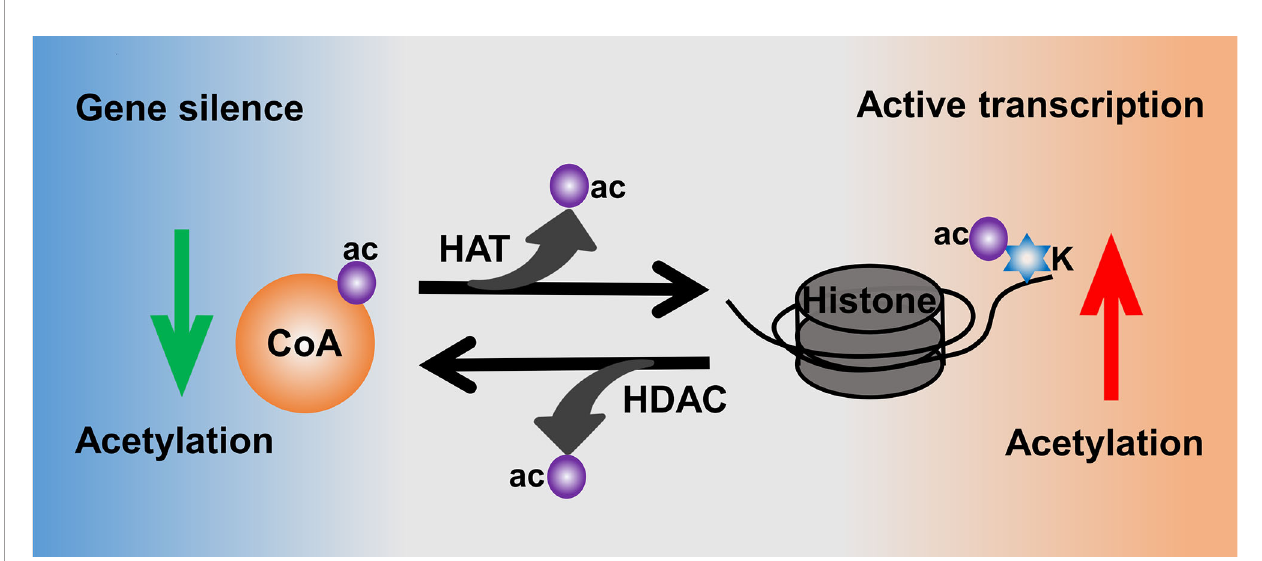
FIGURE 3 | Histone acetylation mediated by the activities of HATs and